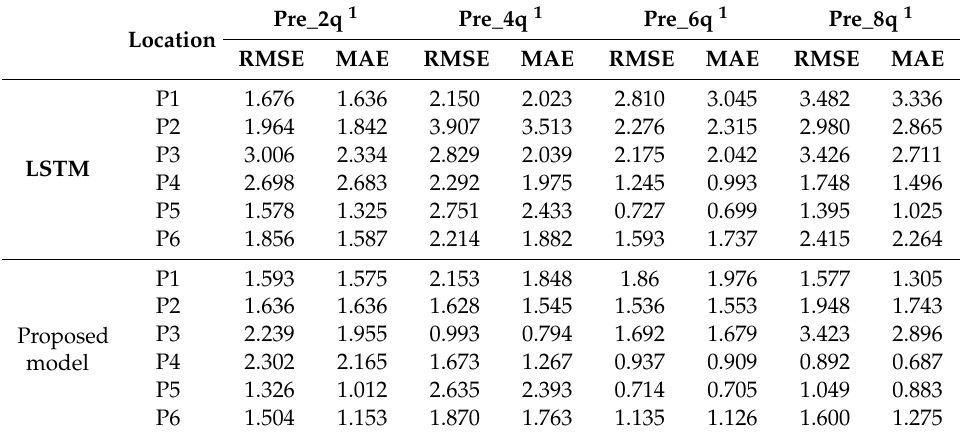
Table 3. Quarterly RMSE and MAE of six sites with different predicted lengths (the unit is °C).